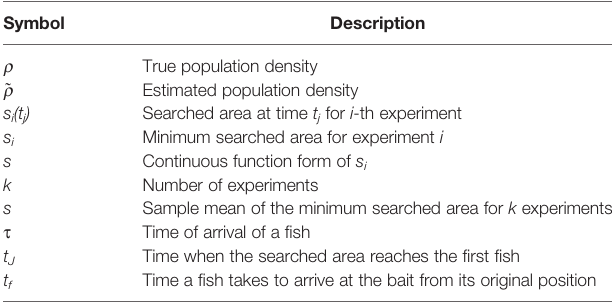
TABLE 1 | Symbols and their descriptions in the theoretical treatment of the ODORA method.